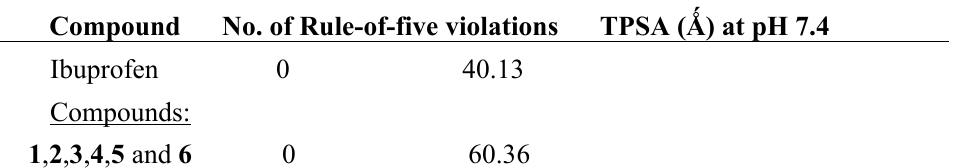
Table 2 . Compliance of compounds to computational parameters of